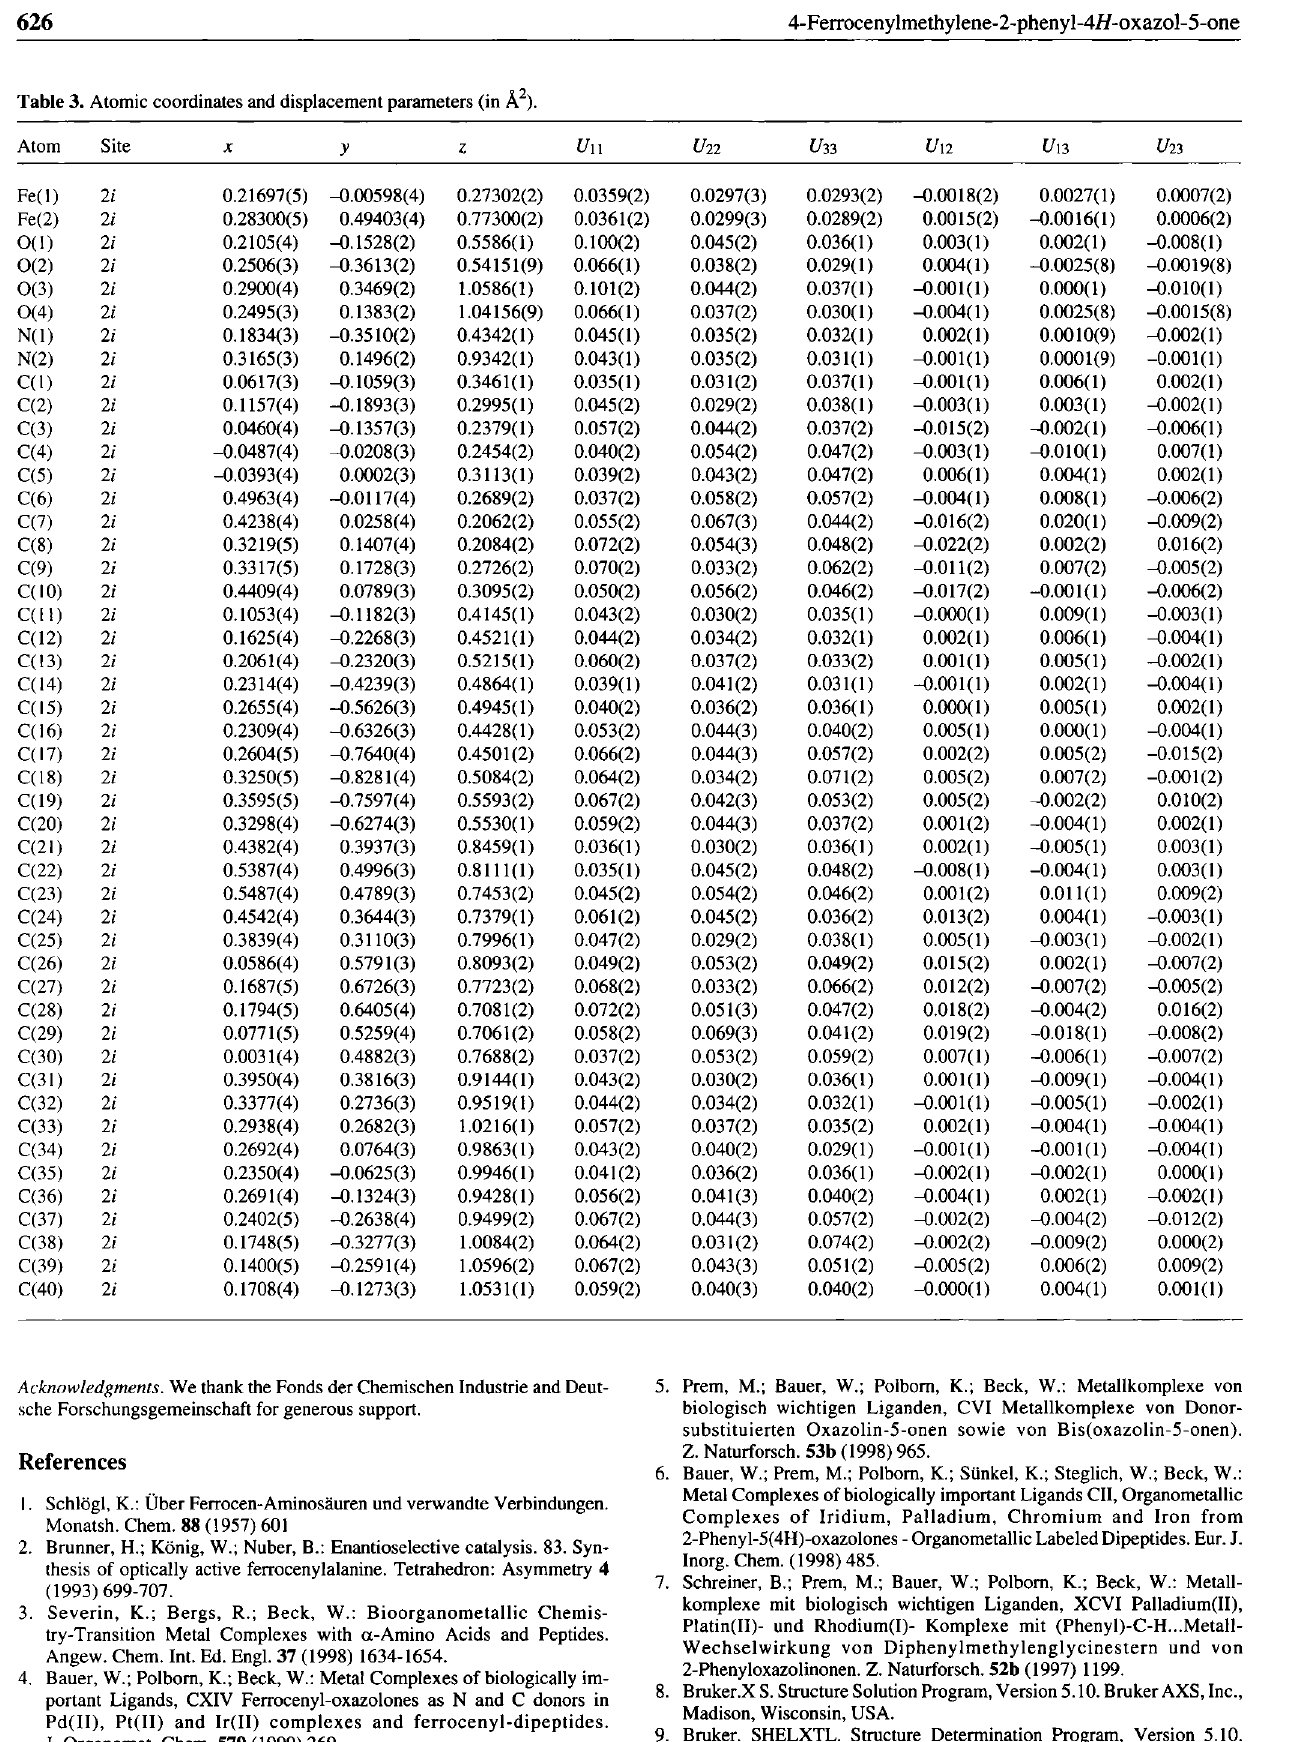
Table 3. Atomic coordinates and displacement parameters (in Â 2